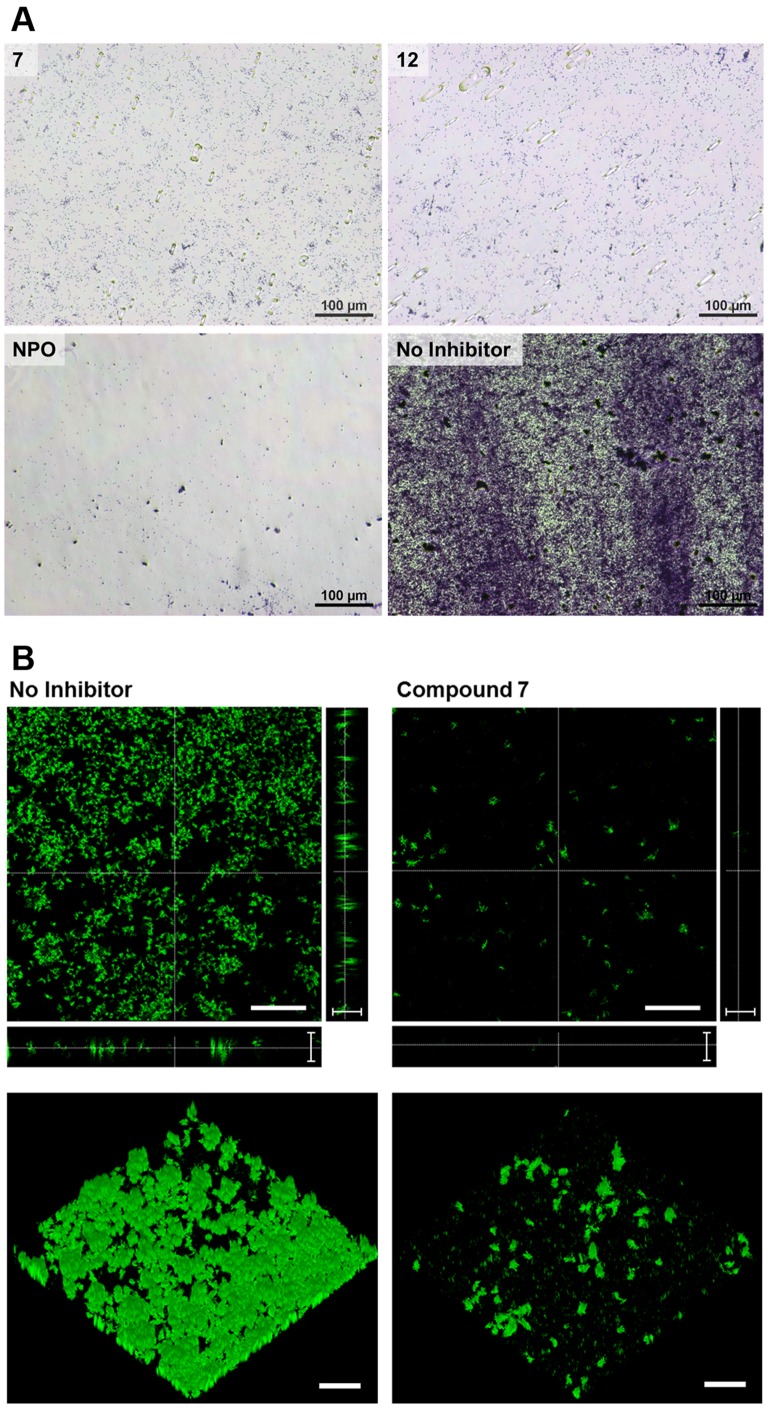
Panel A: Optical micrographs of bacterial biofilms.The films were grown in the presence of small molecule inhibitors 7 and 12 at 1 mM final concentration. Scale bar  = 100 µm. Panel B: Laser scanning confocal micrographs of biofilms. The films were grown in the presence of 1 mM compound 7 (right) or without inhibitor (left). Top down images are shown in the upper views, with vertical and horizontal cross-sections shown to the right and below, respectively. Three dimensional reconstructions are shown in the bottom views. Scale bars for top down and 3D views are 50 µm, while scale bars for cross sections are 10 µm.